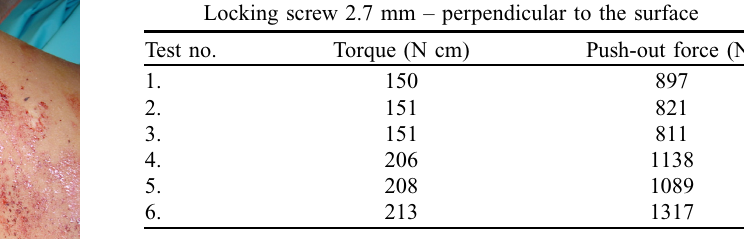
Table 1. Push-out test performed with 2.7 mm locking screws on the polyethylene